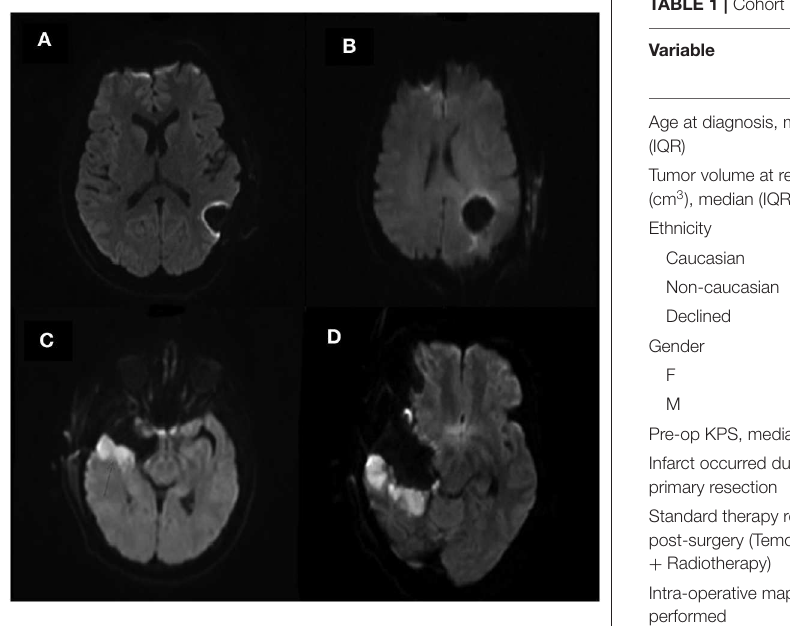
FIGURE 2 | (A–D) Selected example post-operative diffusion (b1000) MRI scans of four separate subjects. (A,B) are representative of subjects in the control cohort. Note the resection cavities seen in the left parietal lobe on both scans which exhibit a minimal rim of hyperintensity surrounding the resection cavity. (C,D) are representative of subjects in the infarct cohort. Note the resection cavity seen in the right temporal lobe on both scans. Also note the larger area of diffusion hyperintensity surrounding the resection cavity representing arterial